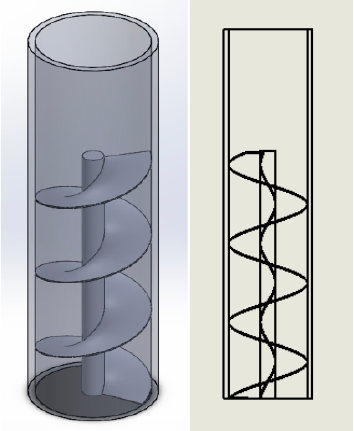
Figure 1. Helicoidal seed tube.